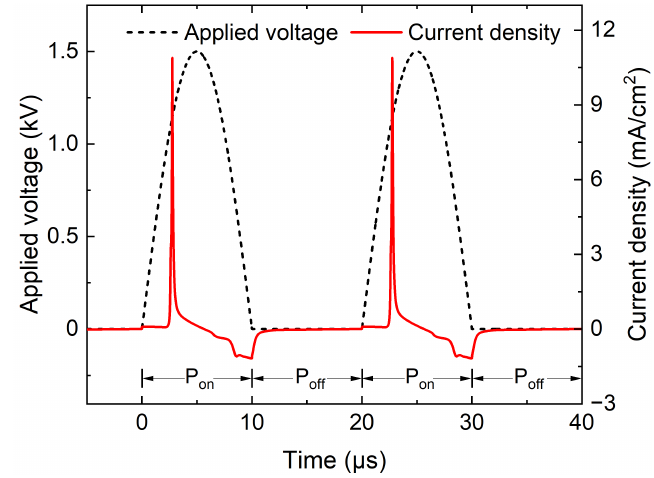
Figure 1. Waveform of applied voltage and corresponding current density in the